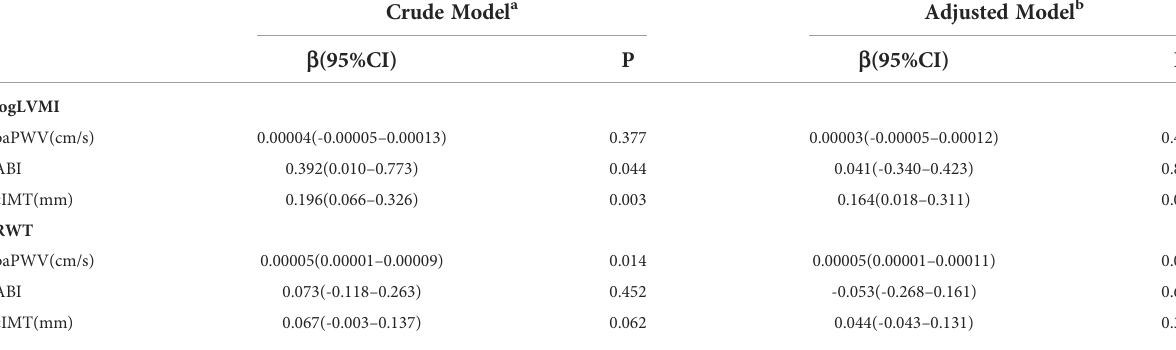
TABLE 3 Linear regression analysis showing the association of LVMI and RWT with vascular